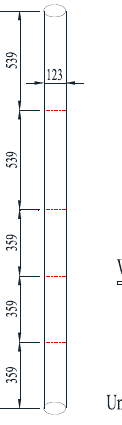
Figure 1. Layout of surface pressure taps on cylinder.